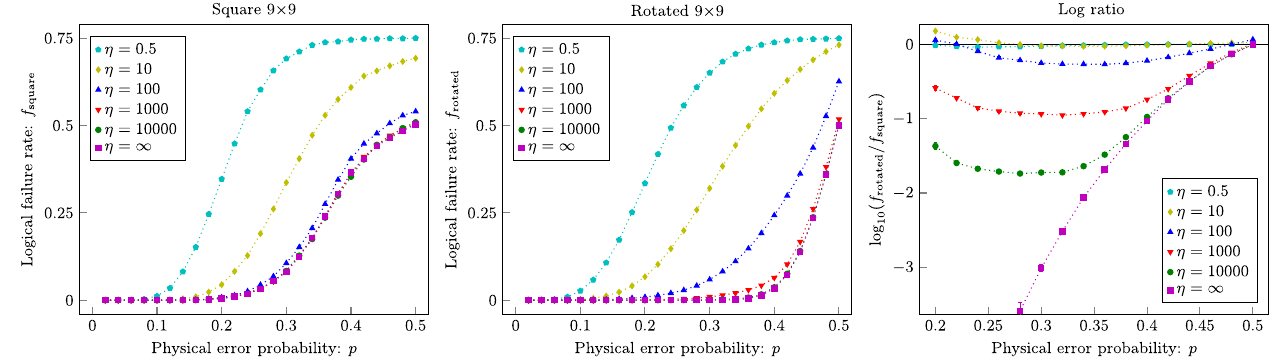
FIG. 2. Logical failure rates f and f as a function of physical error probability p for small comparable square and square rotated =f rotated 9 × 9 codes and the logarithm of the ratio of logical failure rates log 10 ð f with noise biases rotated square Þ η ∈ f 0 . 5 ; 10 ; 100 ; 1000 ; 10 000 ; ∞ g . Error bars indicate one standard deviation. Data points are sample means over 30 000 and 1 200 000 runs for the square and rotated codes, respectively, using approximate maximum-likelihood decoding converged to within half a standard deviation for both codes. Dotted lines connect successive data points for a given η